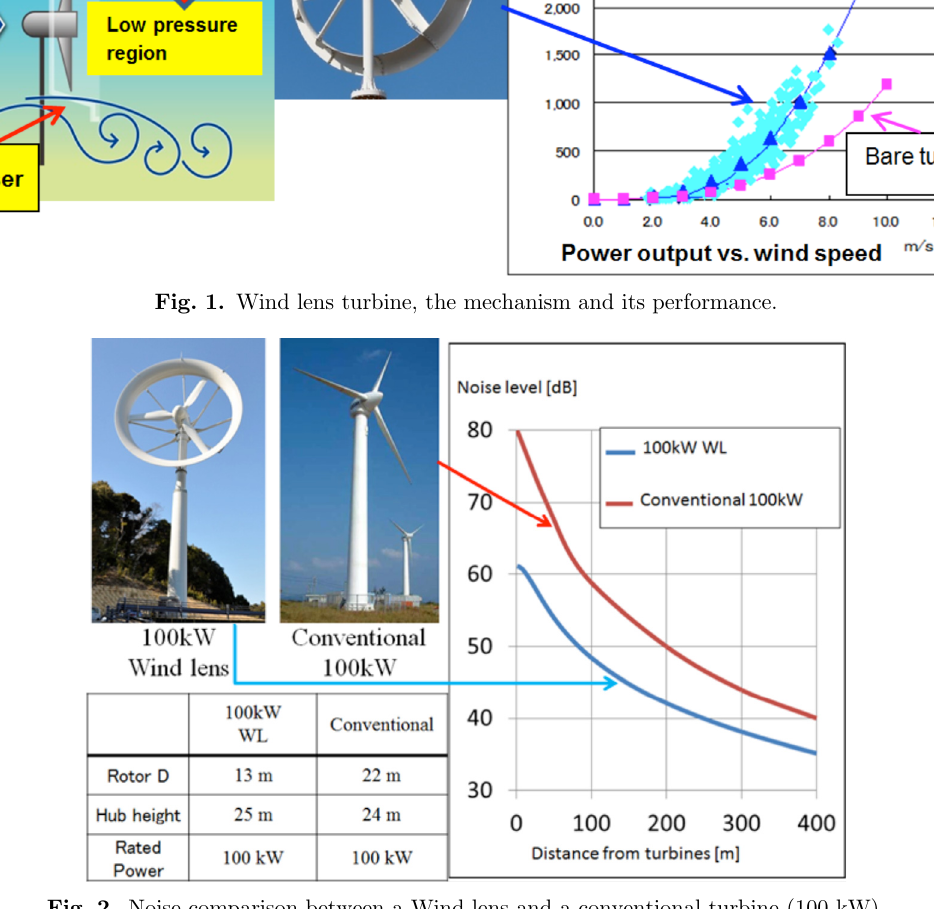
Fig. 2. Noise comparison between a Wind lens and a conventional turbine (100